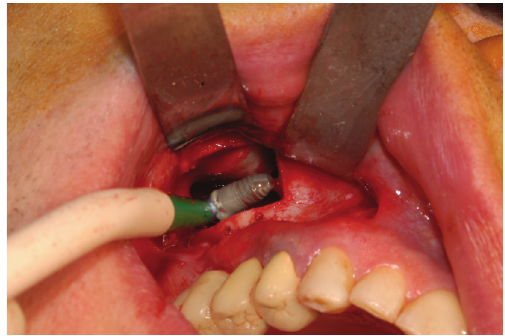
Figure 7: The implant is removed with a surgical aspirator.